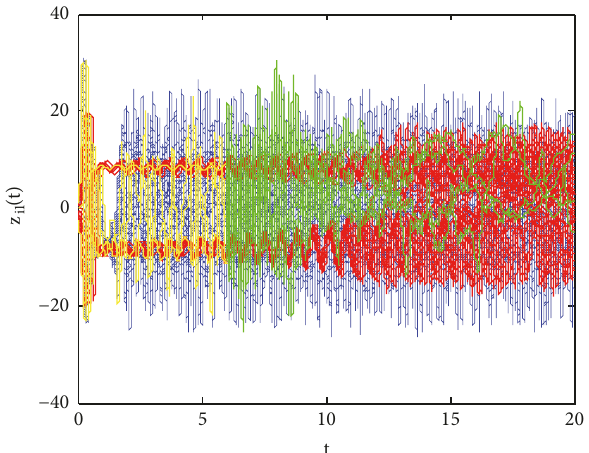
Figure 8: (Color online) Less node control community network 𝑧 (𝑡) with 𝑡 . 𝑖1